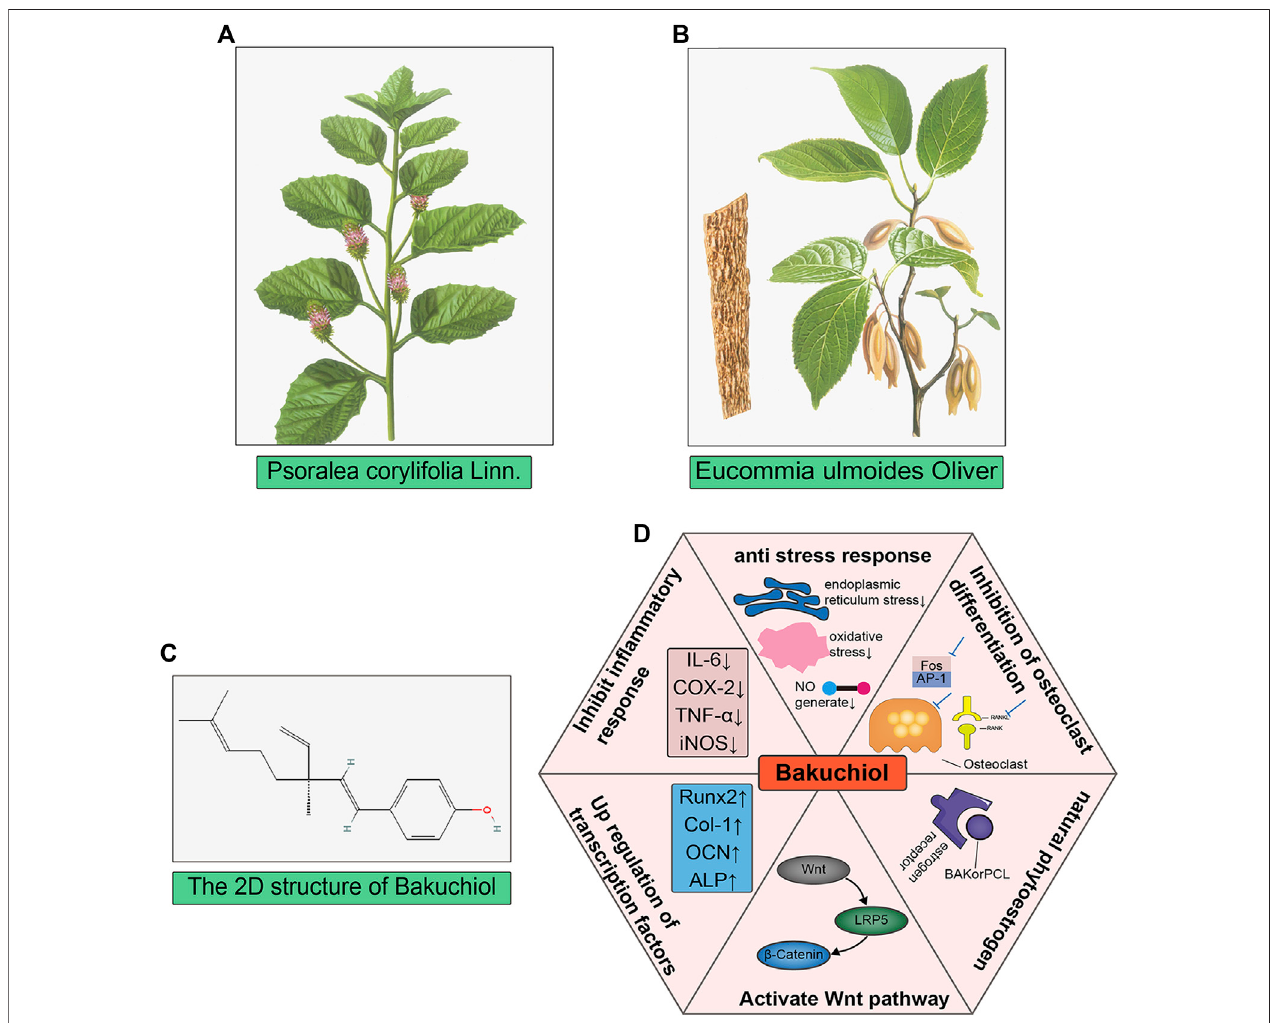
FIGURE3| MechanismdiagramofRANKL/RANK/OPGsignalingpathwaycascadeinosteoclastogenesis.BindingofRANKLtoRANKleadstoTRAF6recruitment and thus activation of NF-kB and MAPK pathways. TRAF6 recruitment activates the NF-kB and JNK/ERK/p38 MAPK signaling pathways, and activation of the transcription factor Fos/AP-1 is also dependent on TRAF6 recruitment and JNK/ERK activation, together, these activated signals lead to activation of NFATc1, a key transcriptionfactorfordownstreamosteoclastformation.Inaddition,RANKLactivationstimulatestheproteinDAP12orFcR γ ofthetyrosine-activatingmotifITAM, forming a complex of phospholipase C- γ and dephosphorylated tyrosinase, which activates calcium ion signaling and induces NFATc1 translocation into the nucleus of osteoclasts, and again here, NFATc1 works together with other transcription factors to induce osteoclast activation, thus NFATc1 is a marker event for osteoclast formation. The osteoclastogenesis inhibitory factor competitively binds RANKL and inhibits osteoclast differentiation thereby reducing osteoclast production.